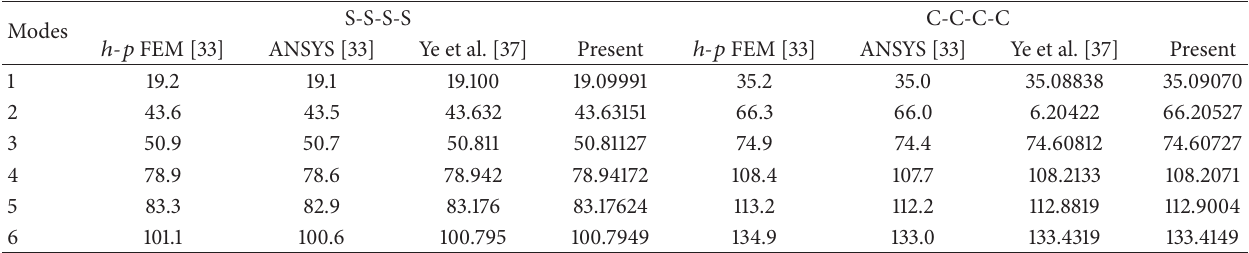
Table 8: Comparison of the first six frequency parameters Ω = 𝜔𝐿 2 √𝜌ℎ/𝐷 for an open conical shell with various boundary conditions.